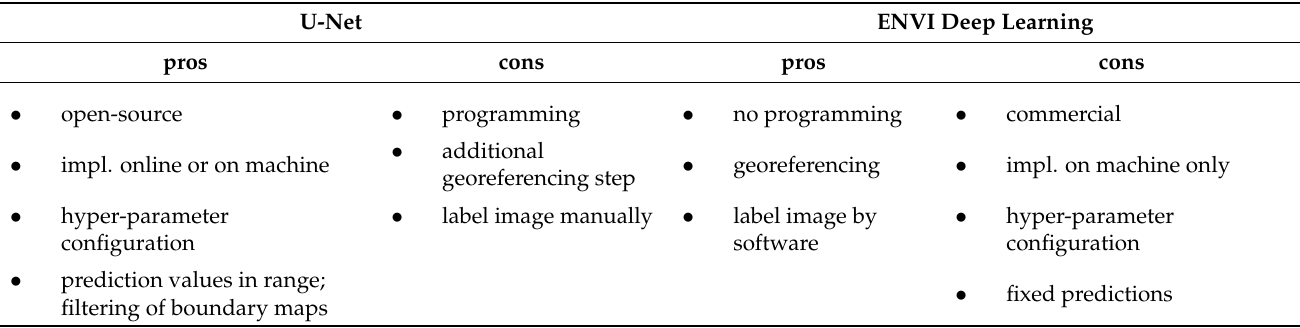
Table 7. Summarized advantages (pros) and disadvantages (cons) for boundary mapping approaches used in this